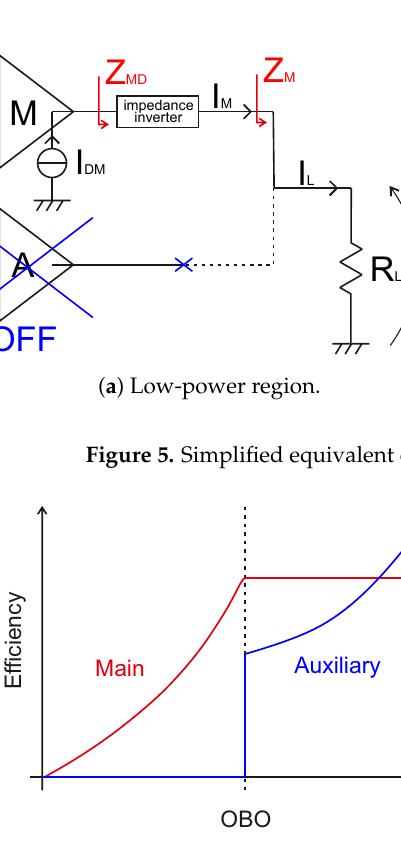
Figure 6. Doherty power amplifier efficiency. Curves are representative of a Class-AB/C Doherty